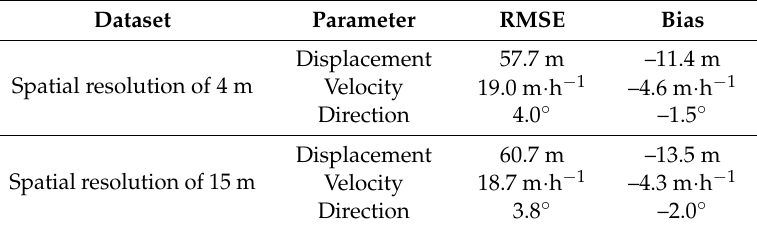
Table 5. Quality assessment of the sea ice motion measurement by comparing the image-derived motion vectors with the motions connecting the time-interpolated buoy locations.